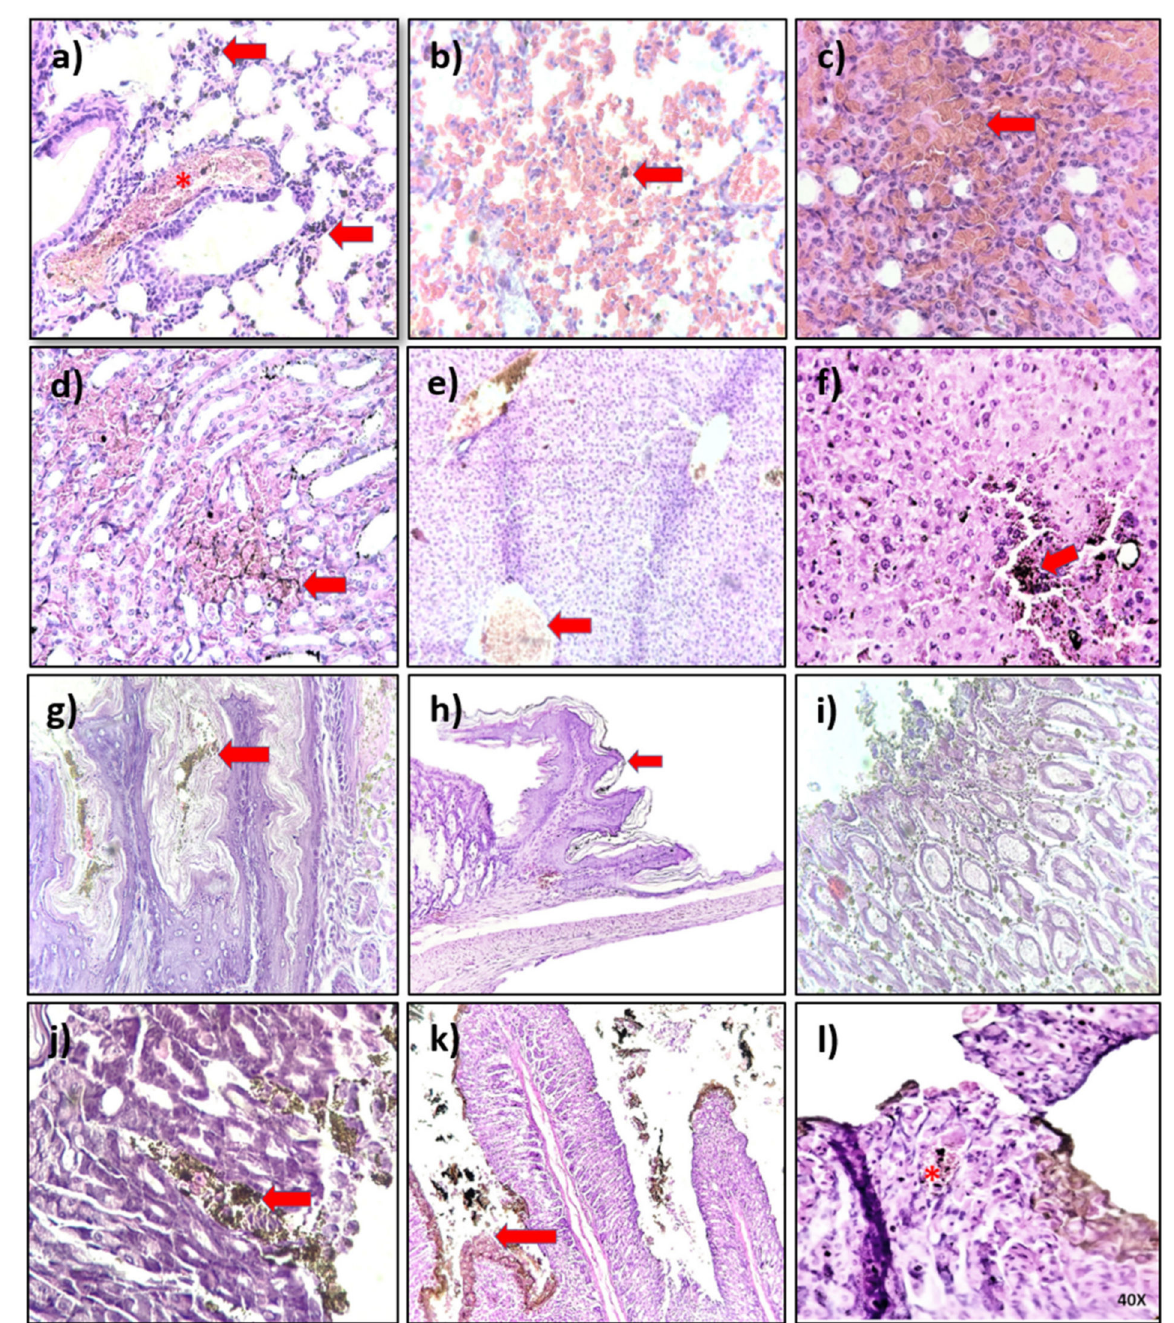
Figure 5. Histological analysis of mice organs exposed to AgNPs formulations AgNP1–AgNP5. The photographs are representative of the damage, when observed, on the lung ( a , b ); kidney ( c , d ); liver ( e , f ); esophagus ( g ); gastroesophageal union ( h ); stomach ( i , j ), and intestine ( k , l ). Red arrows indicate accumulation of dark non-cellular material. Asterisks show cellular